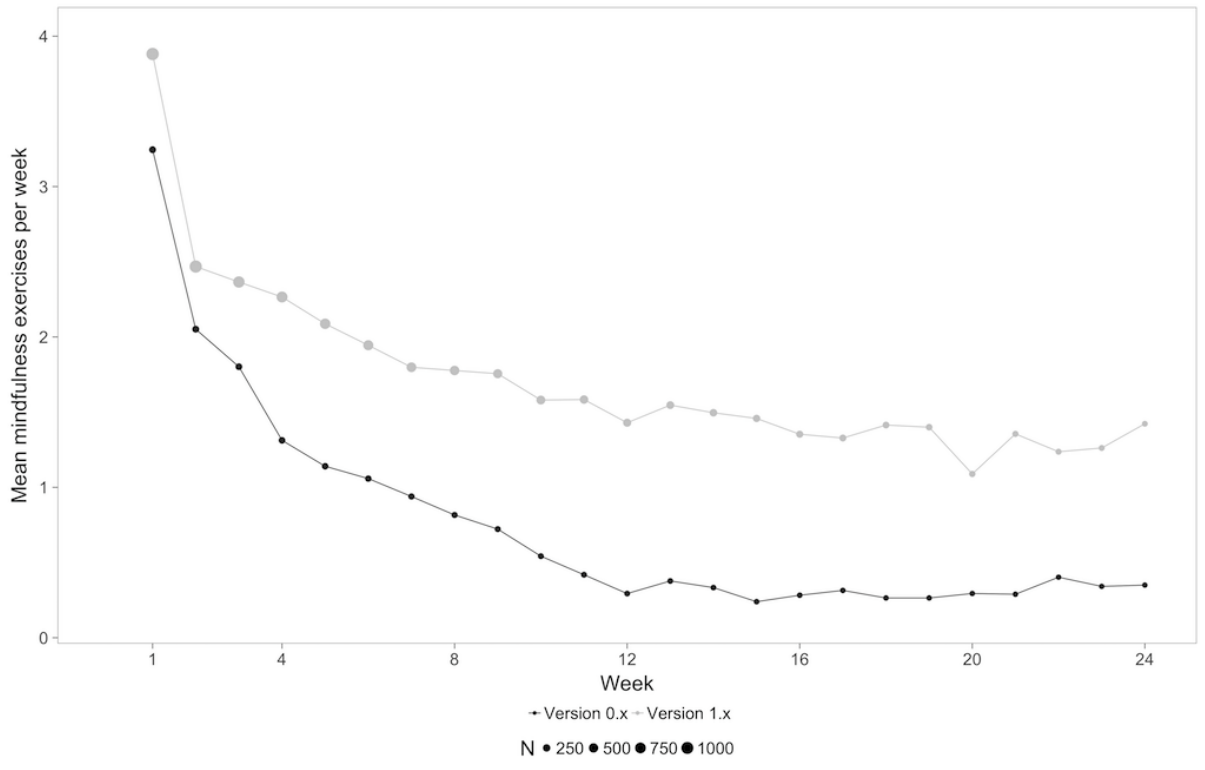
Figure 3. Mean mindfulness exercises per week for each content type over time for both